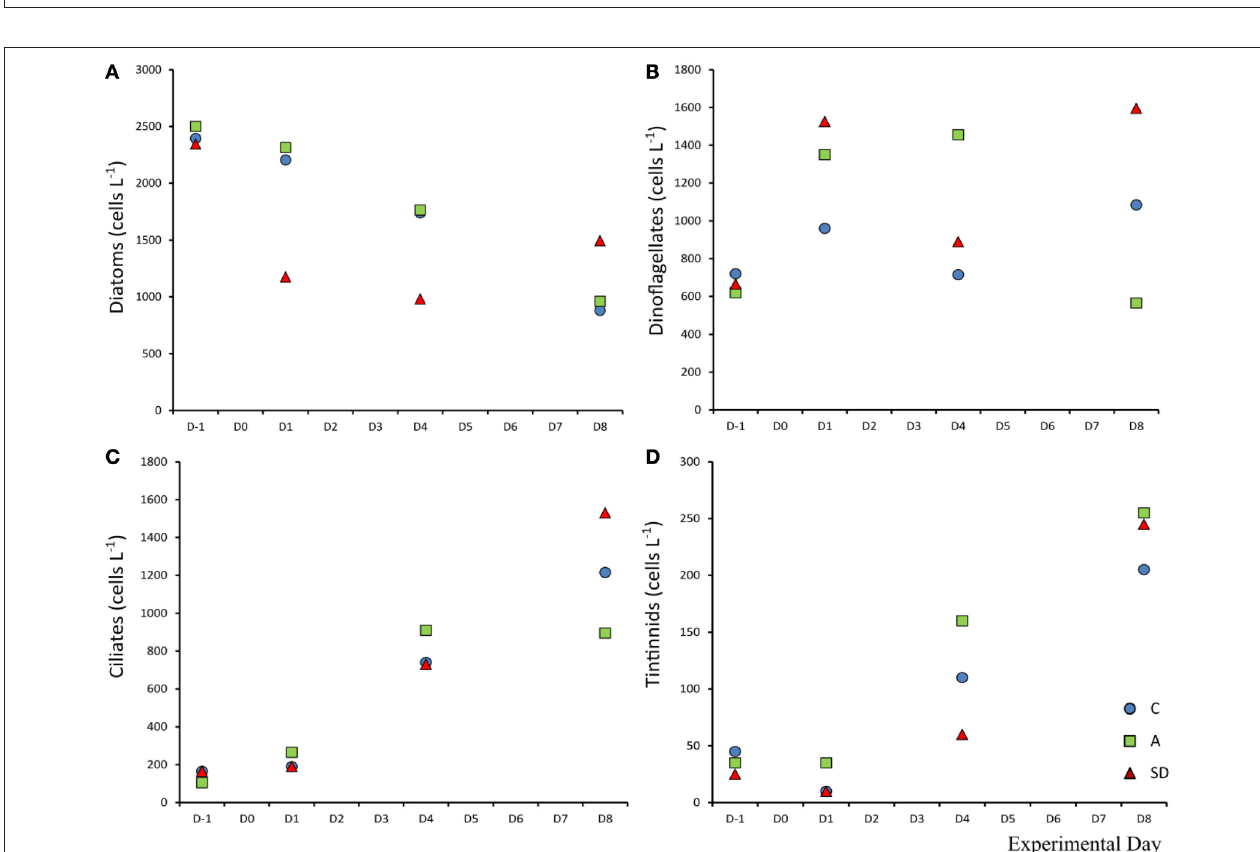
FIGURE 11 | Abundance of diatoms (A) , dinoflagellates (B) , ciliates (C) , and tintinnids (D) in each treatment.